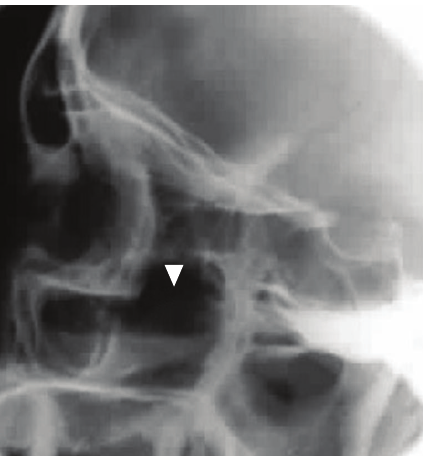
Figure 1: Lateral plain X-ray showing air-fluid level in the maxillary sinus.